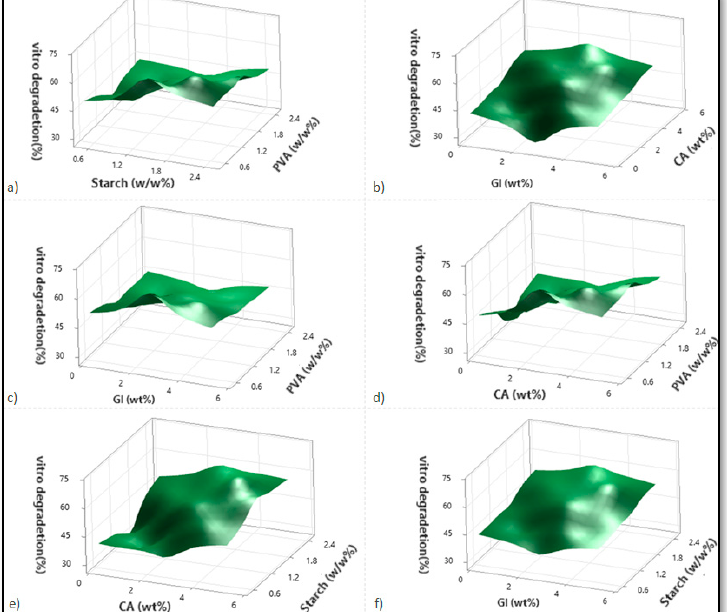
Figure 3. The corresponding response surface plots show the independent variables’ effects on weight loss (WL%). ( a ) Starch-PVA, ( b ) Glycerol-Citric acid, ( c ) Glycerol-PVA, ( d ) Citric acid-PVA, ( e ) Citric acid-Starch, and ( f ) Glycerol-Starch.